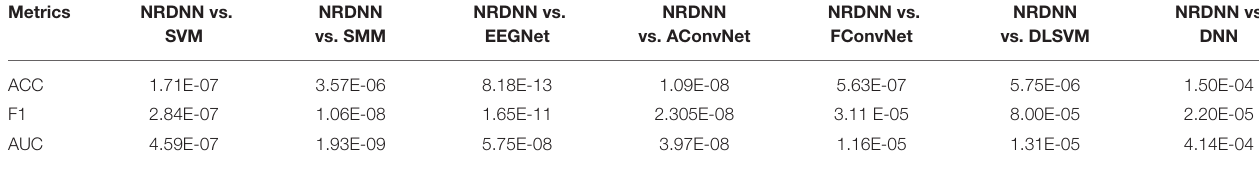
TABLE 6 | Statistical significance comparisons of ACC and F1 of NRDNN and other comparison methods. Metrics